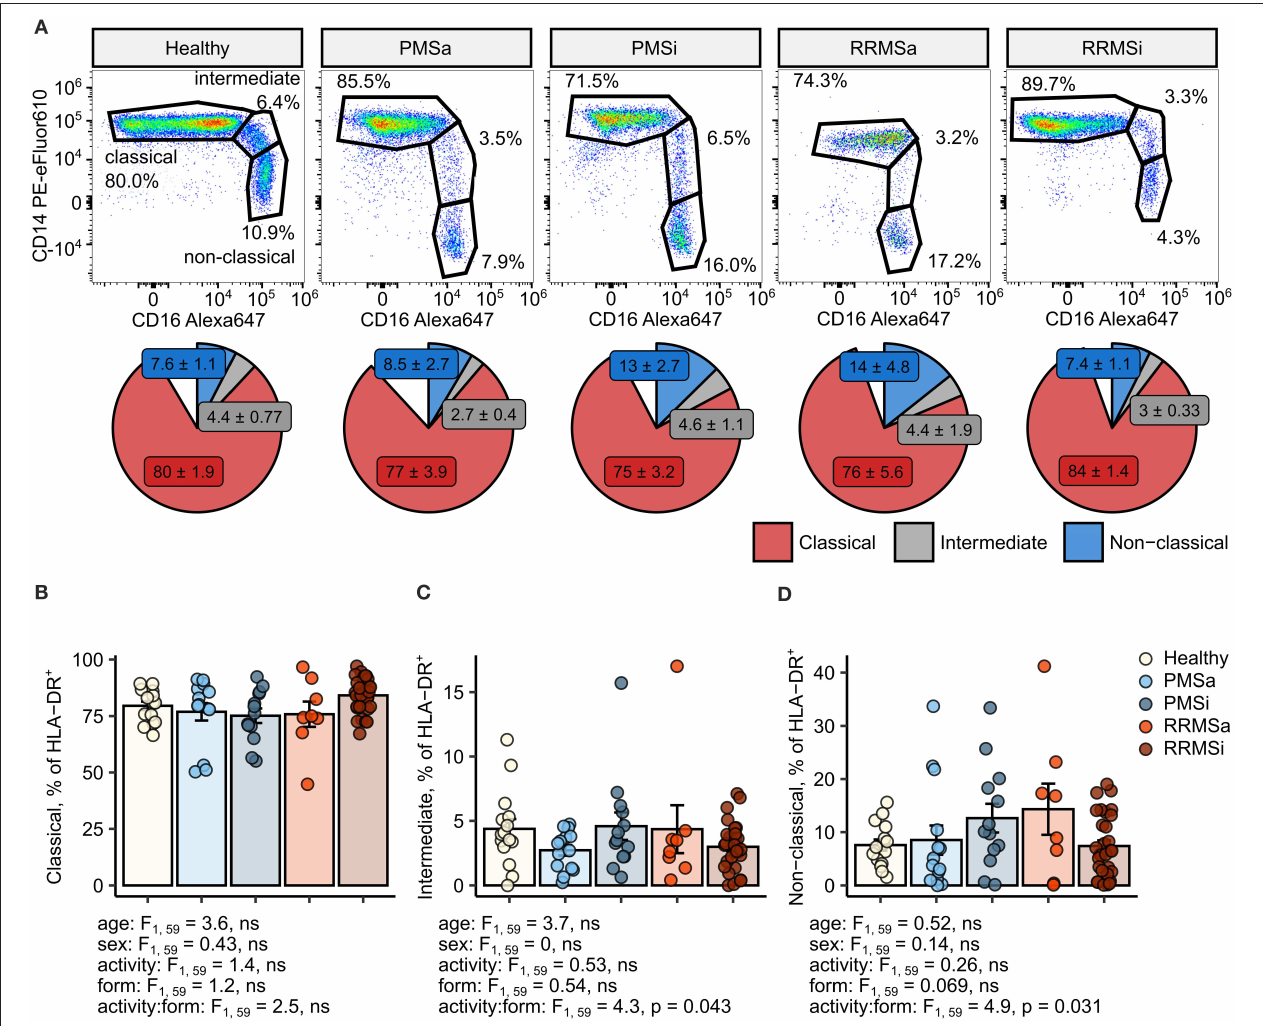
FIGURE 1 | Minor alterations of monocyte subtype distribution pattern in multiple sclerosis (MS) course types. Classical, intermediate, and nonclassical monocytes were identified in whole-blood samples from healthy controls ( n = 15) and MS patients stratified by disease course type [active progressive MS (PMSa): n = 14, inactive progressive MS (PMSi): n = 13, active relapsing-remitting MS (RRMSa): n = 8, and inactive relapsing-remitting MS (RRMSi): n = 30] as presented in Supplementary Figure S1 . (A) Representative results of CD14 and CD16 staining in CD45 + Lineage − CD15 − HLA-DR + pan-monocytes are shown. Pie plots display levels of monocyte subtypes expressed as percentage of CD45 + Lineage − CD15 − HLA-DR + pan-monocytes. Means with SEM are presented. (B–D) Levels of monocyte subtypes expressed as percent of CD45 + Lineage − CD15 − HLA-DR + pan-monocytes. Each point denotes a single observation, bars depict